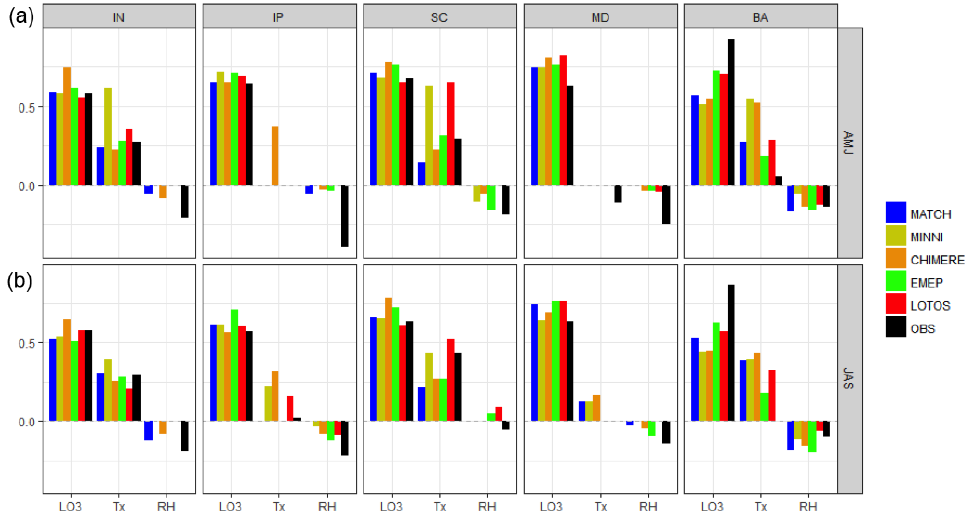
Figure 9. Standardised coefficients values of the main key-driving factors (LO3, Tx and RH) for each CTM-based (ordered as in Fig. 3) and observation-based MLR in AMJ (a) and JAS (b) and for the external regions: Inflow (IN), Iberian Peninsula (IP), Scandinavia (SC), Mediterranean (MD) and Balkans